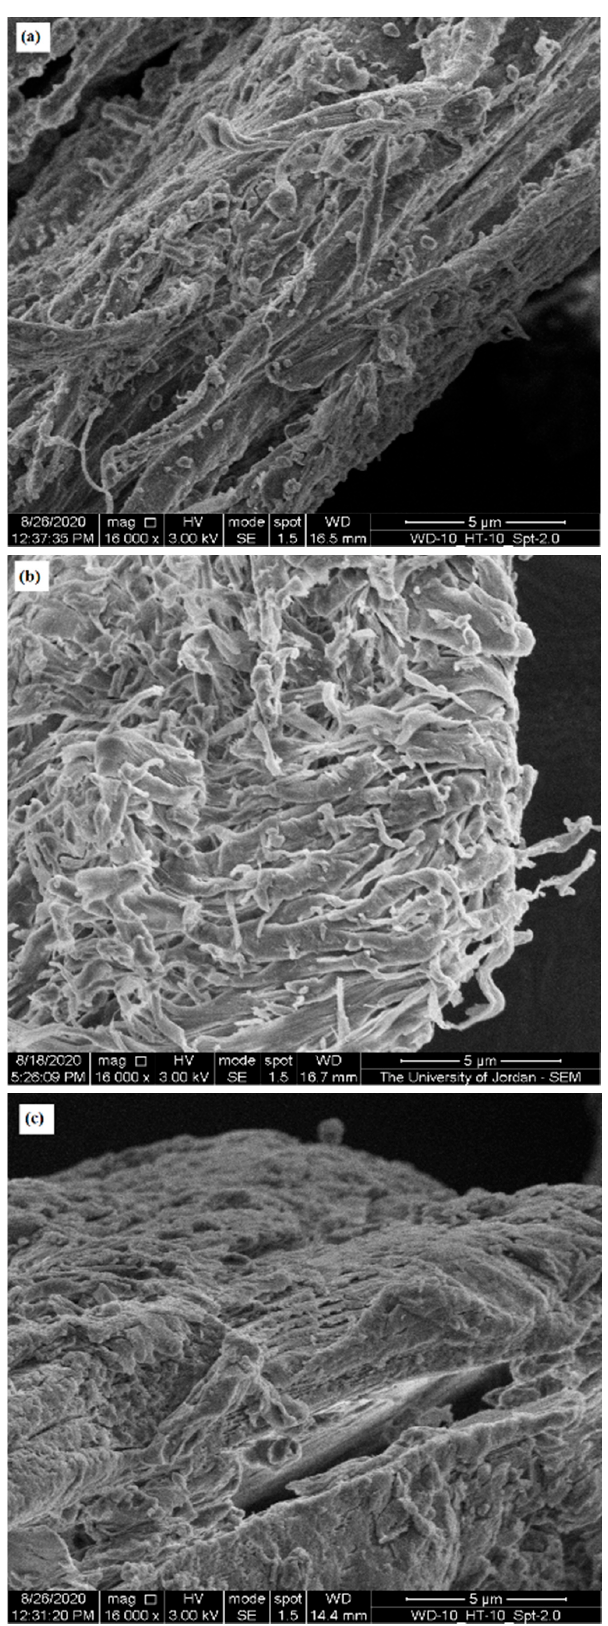
Figure 4. SEM image of ( a ) crab (CH-Cr), ( b ) shrimp (CH-Sh), and ( c ) squid (CH-Sq) CHs at 16,000× magnification.